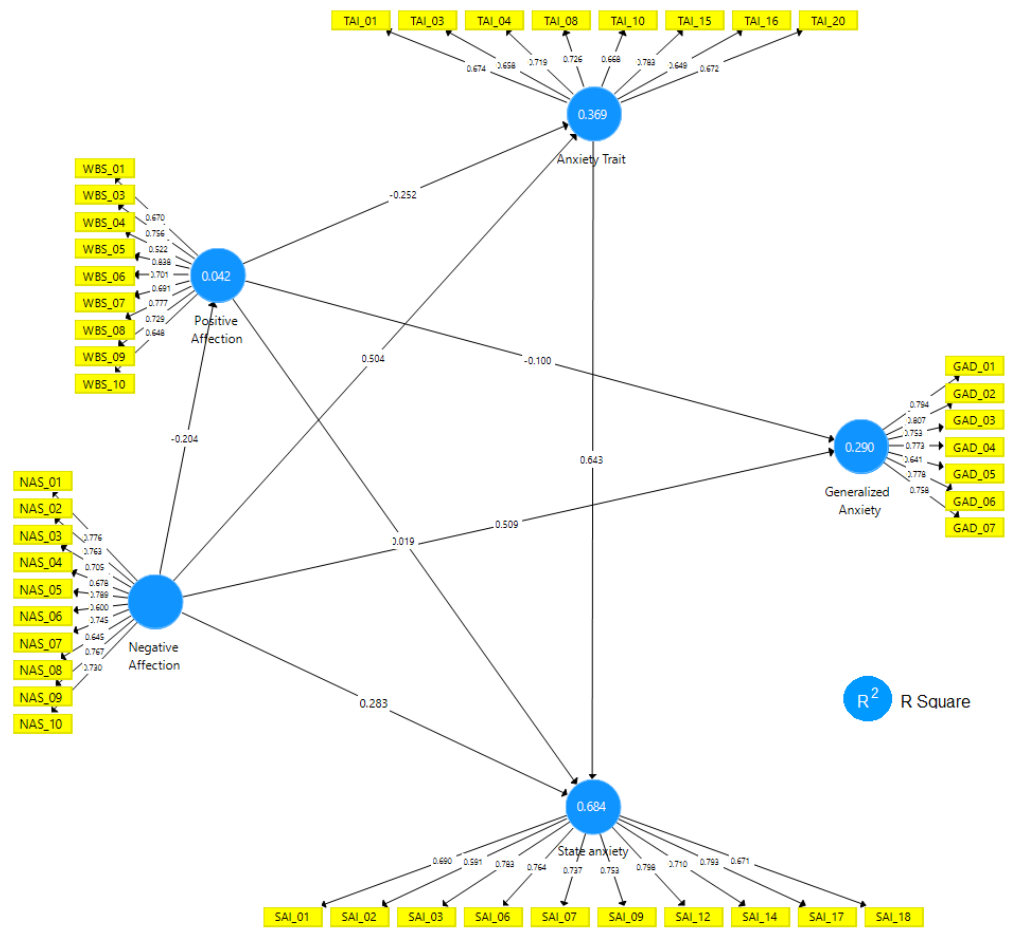
Figure 3. PANAS, GAD-7 and IDATE scale path model Source: SmartPLS ® software, v. 3.3.2 [44].